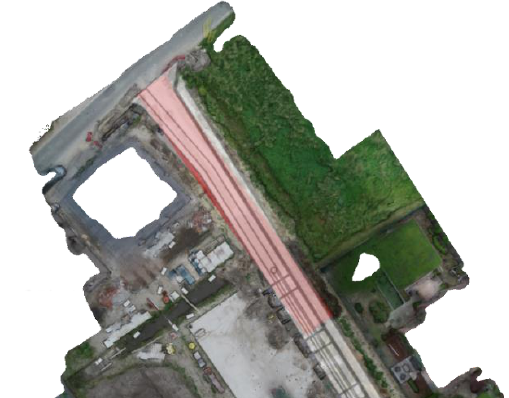
Figure 6. Detection of sewers out of a georeferenced picture compared to the as-design BIM from the same position.